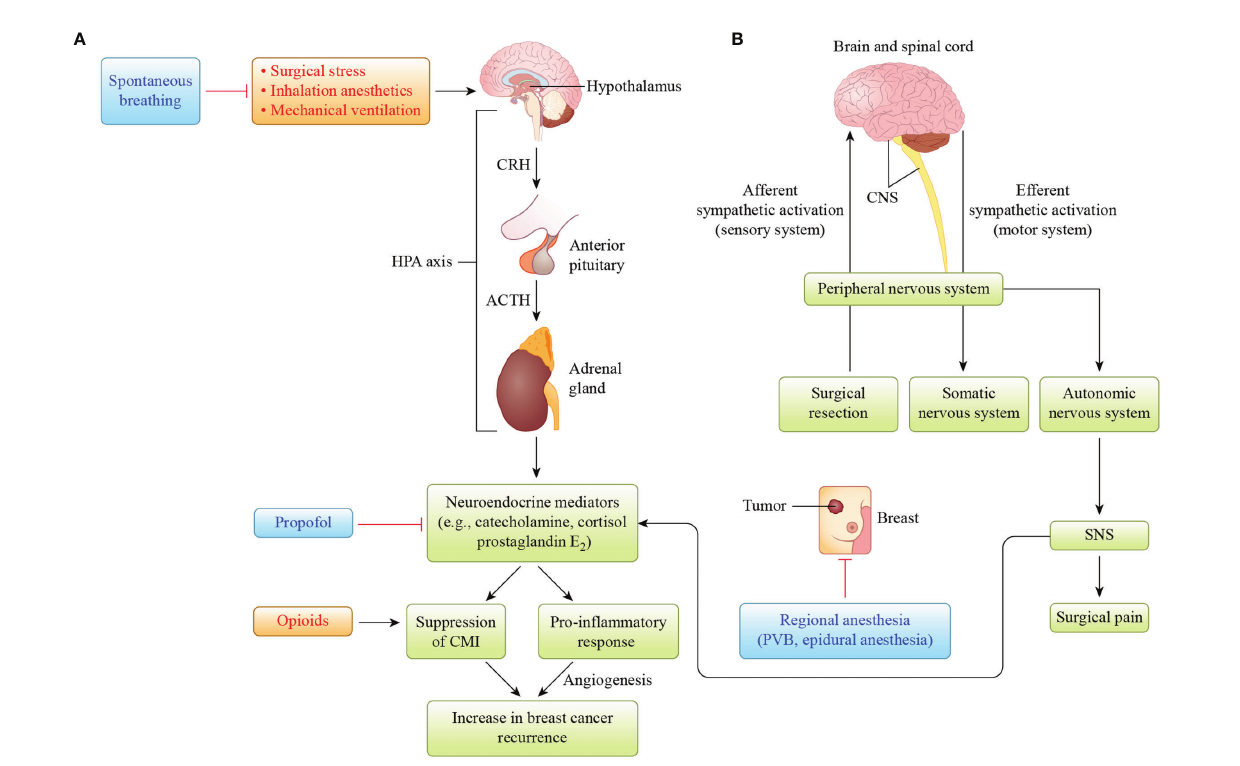
FIGURE 1 | Illustration of the hypothesis that hypothalamus – pituitary – adrenal (HPA) axis and sympathetic nervous system (SNS) activation by surgical stress, inhalation anesthetics, and mechanical ventilation is involved in increased breast cancer recurrence. (A) Activation of the HPA axis results in the release of neuroendocrine mediators such as catecholamine, cortisol, and prostaglandin E 2 . These mediators suppress cell-mediated immunity (CMI), resulting in host immunosuppression, and produce pro-in fl ammatory cytokines to induce angiogenesis, which has been associated with increased breast cancer recurrence. Propofol protects against CMI suppression mediated by neuroendocrine mediators, whereas opioids suppress CMI. (B) When breast cancer surgery activates the afferent nervous system from the peripheral to the central nervous system (CNS), it activates the efferent nervous system from the CNS to the peripheral nervous system, autonomic nervous system, and sympathetic nervous system (SNS), which releases neuroendocrine mediators. Regional anesthesia, such as paravertebral blockade (PVB), or epidural anesthesia inhibits the SNS-induced release of neuroendocrine mediators. Reciprocal activation of the HPA axis and SNS by surgical stress and/or inhalation anesthesia may increase breast cancer recurrence. CRH, corticotropin- releasing hormone; ACTH, adrenocorticotropic